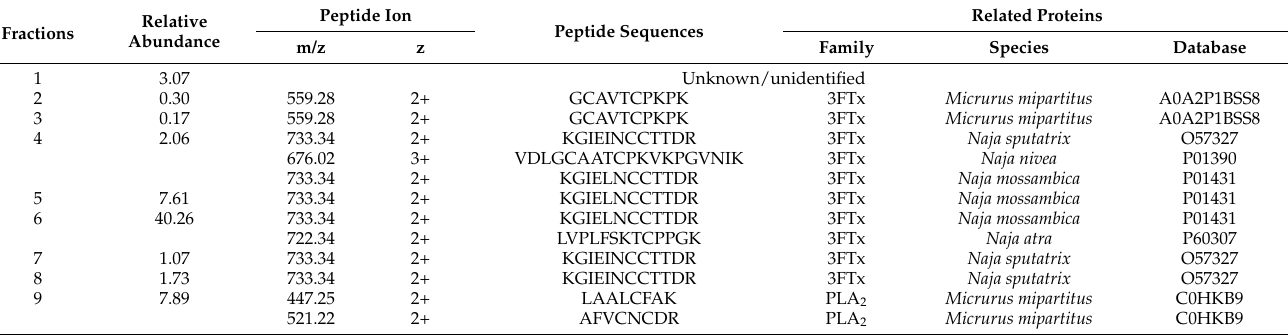
Table 2. Overview of MS/MS identification of M. mipartitus toxins found in SDS-PAGE gel and/or RP- HPLC fractions. Protein assignment was achieved by matching MS/MS derived peptide sequences with snake venom toxin